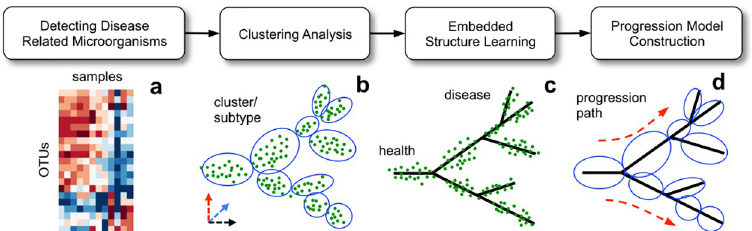
Fig 1. Overview of the proposed bioinformatics pipeline for microbial community dynamics analysis. The pipeline offers an integrated suite of computational tools that allow researchers to identify disease-related microorganisms, stratify samples into clinically relevant subtypes, construct disease progression models, and delineate disease-specific community dynamics at both organism and functional